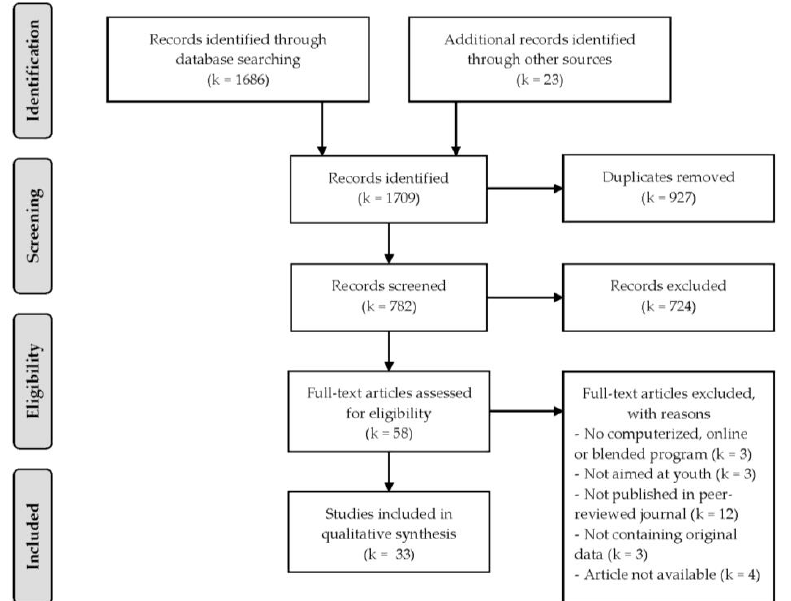
Figure 1. Flow chart of study selection.